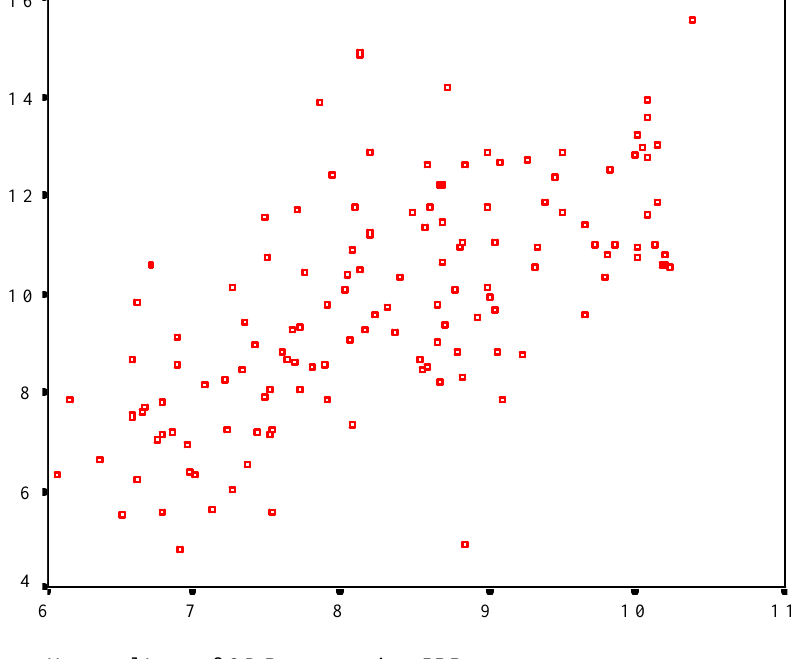
Natura l Log of GDP p er c apita ,